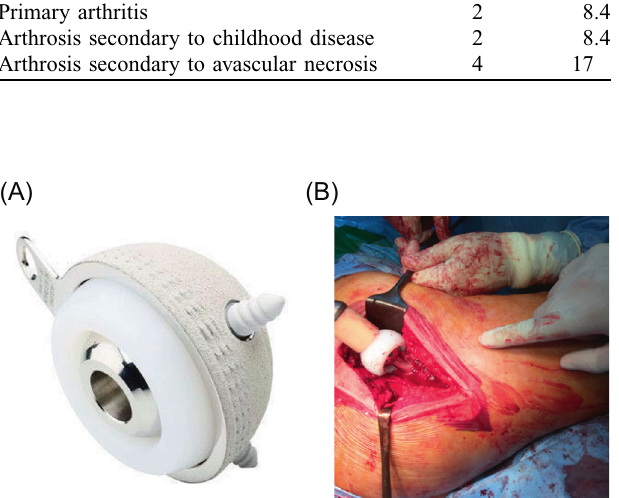
Figure 1. (A) Novae (cid:4) cup used in the cases, a tripod cup that contain a superior fixation screw and two anchorage studs, (B) intraoperative photo during impaction of the PE liner over 22.5 mm head prior to